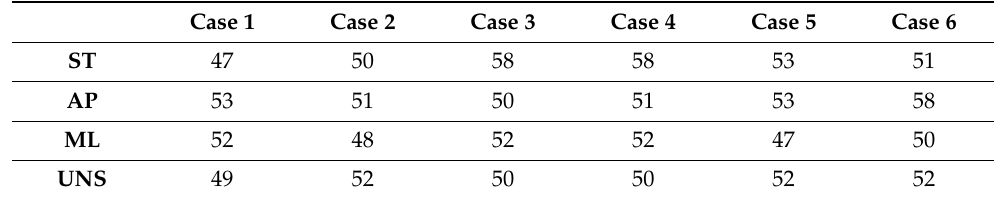
Table 1. The adopted dataset, including different postural movements (Standing (ST), Antero- Posterior (AP), Medio-Lateral (ML), Unstable (UNS)), and cases stated for node positions. Quantities indicate the number of patterns achieved under each